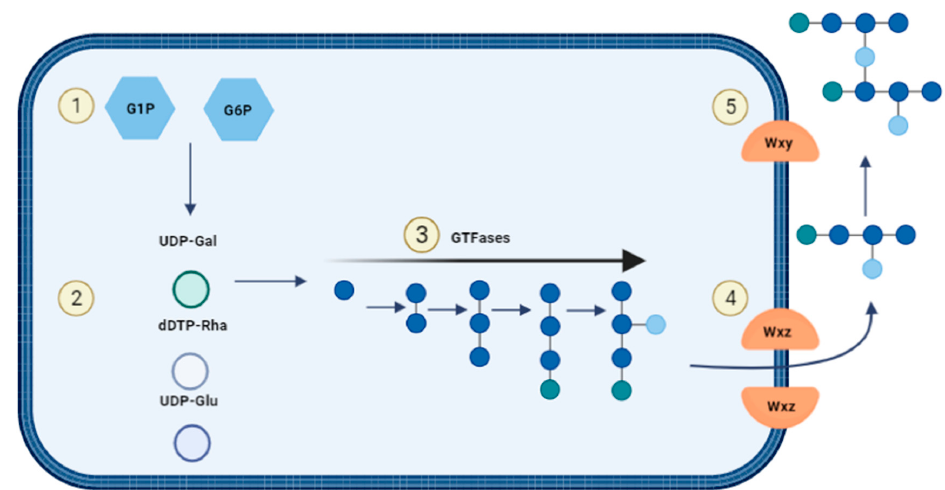
Figure 7. Biosynthesis of heterosaccharides.